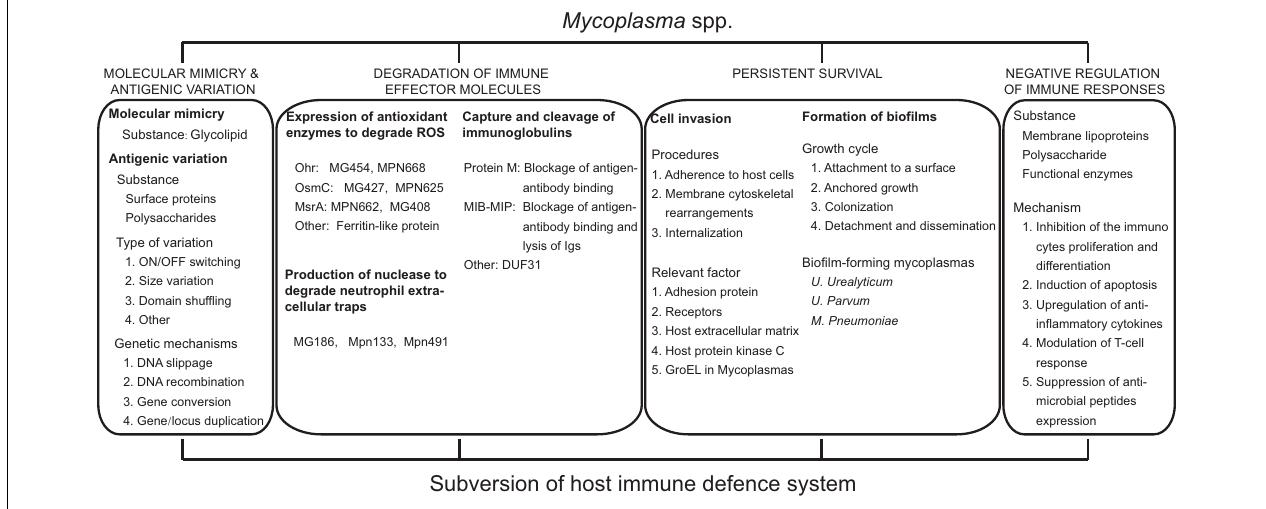
mgpB and mgpC encoding P140/MG191 and P110/MG192, respectively, were indispensable for the adherence and